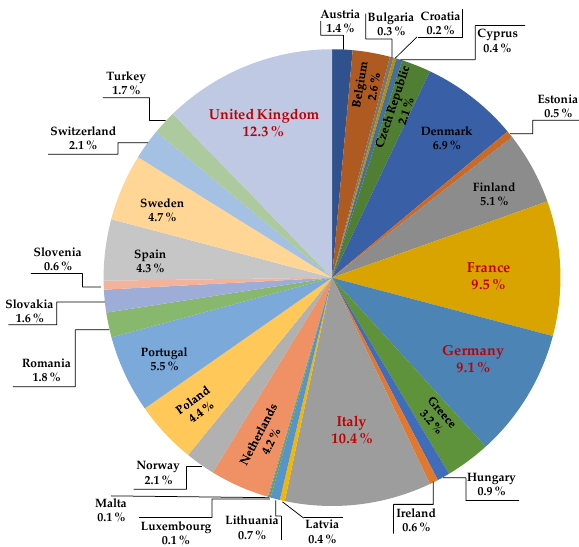
Figure 1. Percentage of country contributions to the total amount of publications on indoor air quality (IAQ) in Europe from 2000 to 2020. (Source: Scopus, search: 19 January 2020); includes Norway, Switzerland, Turkey, and the UK, which is to be expected to leave UE on 31 January 2021.